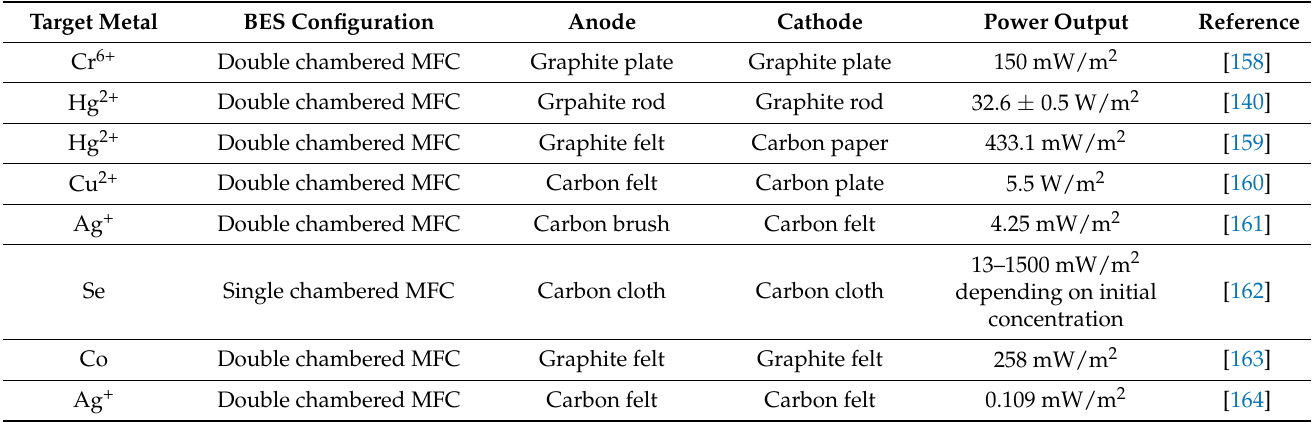
Table 7. Carbon based materials as electrodes for bioelectrochemical reduction of heavy